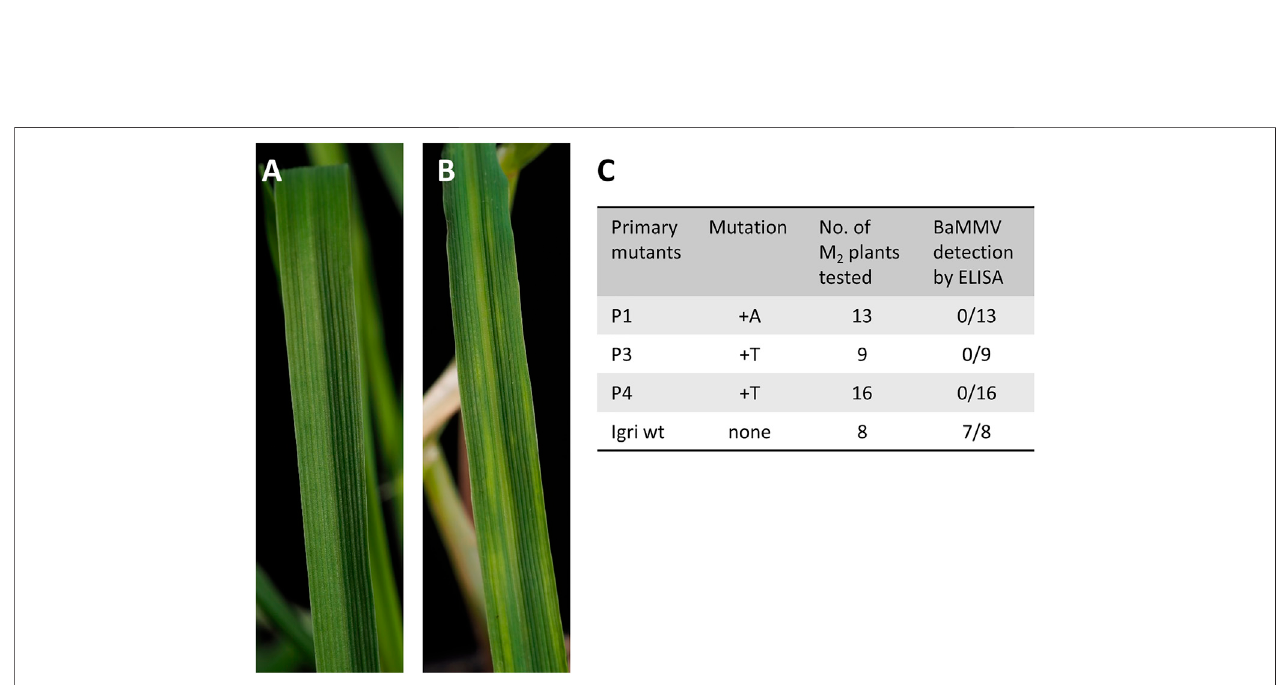
FIGURE3|(A) Healthyleafofwinterbarley “ Igri ” approximately2 monthsaftersowing. (B) Symptoms ofBarleyMildMosaicVirus (BaMMV)infection7 weeksafter mechanical inoculation of wild-type “ Igri ” . (C) Results from mechanical BaMMV inoculation of M2 plants followed by DAS-ELISA for detection of virus particles and concomitant molecular characterization of mutation status. All M2 plants carried the same mutation as their parental plant, con fi rming homozygosity of the latter. All mutants proved resistant against BaMMV infection.